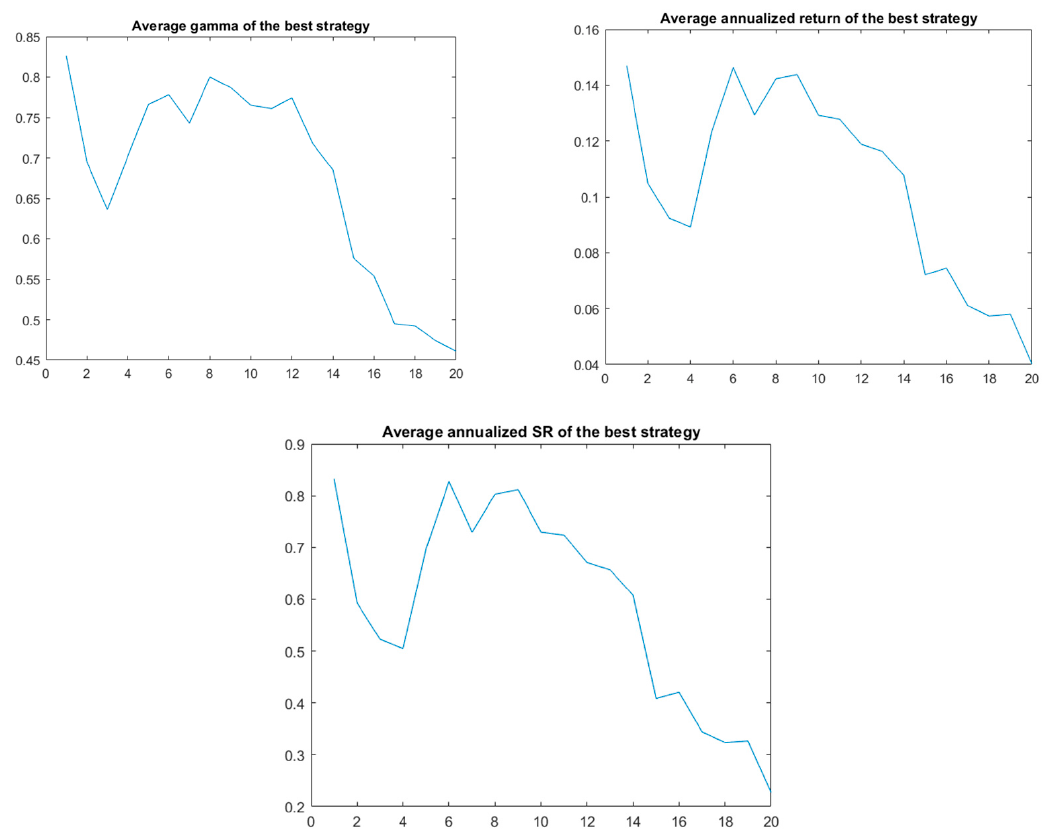
Figure 17. Estimated values of the average ex post gamma, mean return, and SR depending on the number of strategies tested.